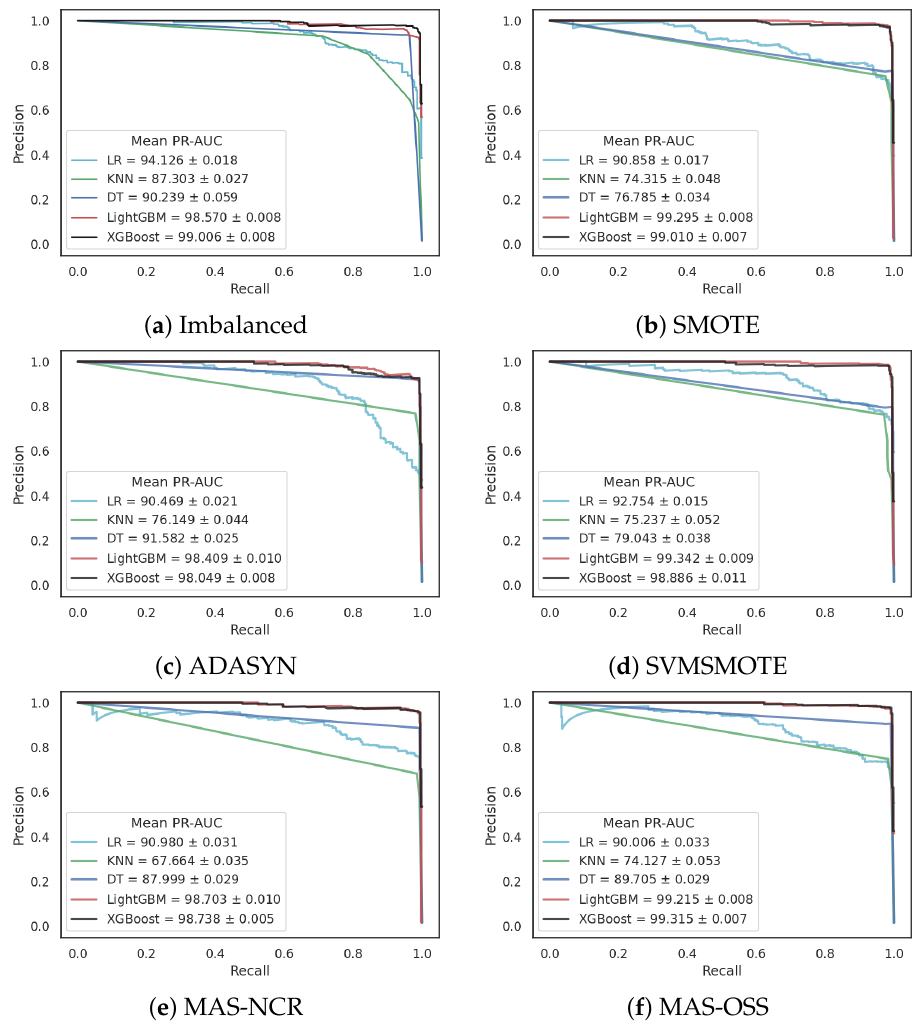
Figure 6. Precision–recall curves for different sampling settings on enterprise